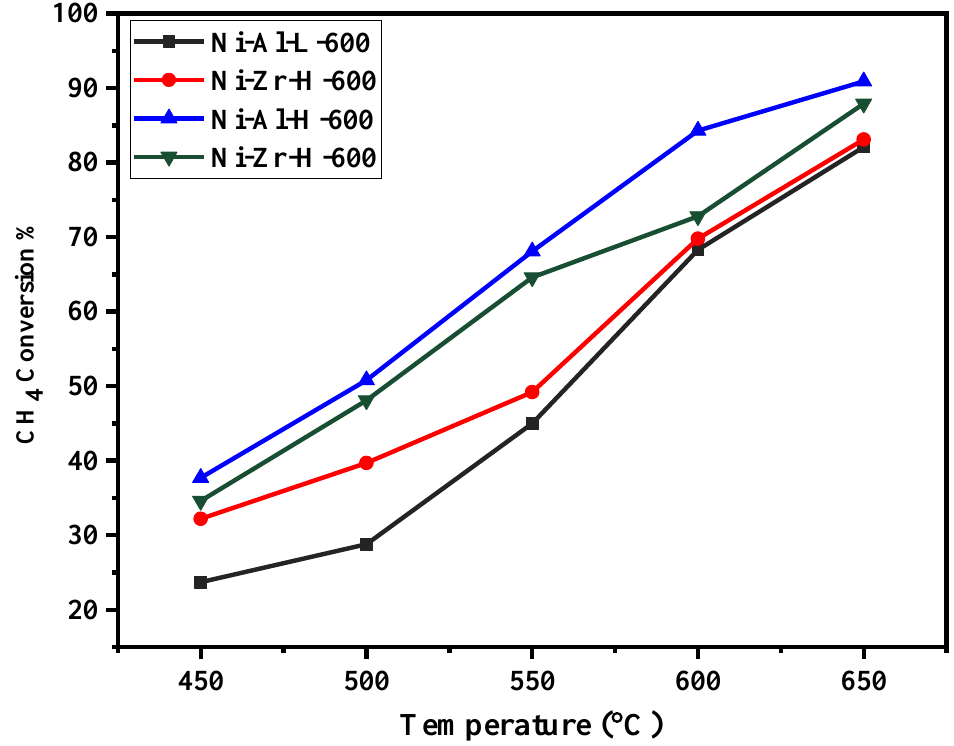
Figure 6. Catalytic activity of catalysts calcined at 600 °C: CH 4 conversion against reaction temperature (450–650 °C).